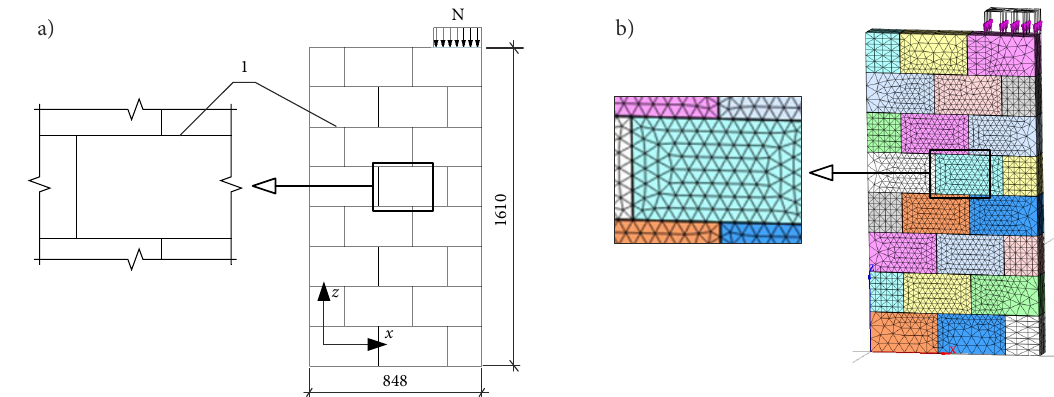
Figure 4. Numerical model of calcium silicate blocks masonry fragment: a) dimensions of fragment;